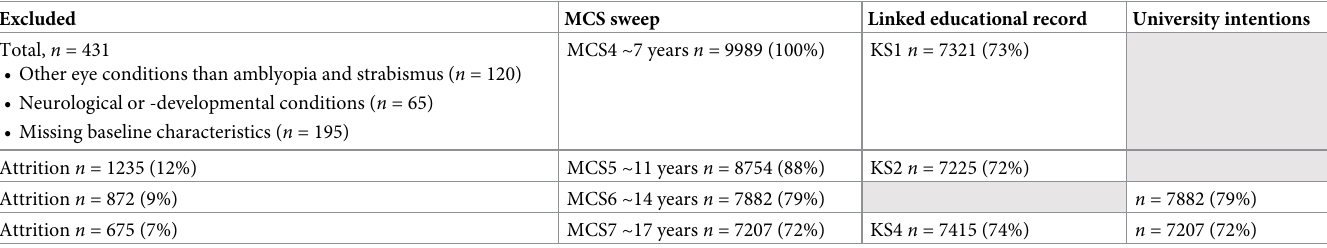
Table 1. Study population of